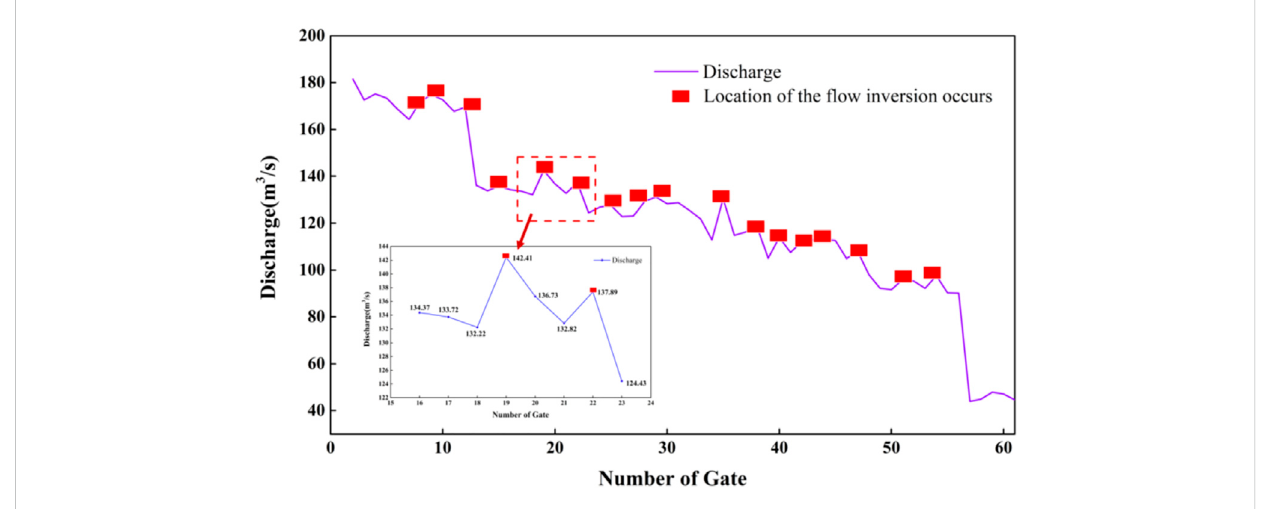
FIGURE 2 Study period to control the fl ow of